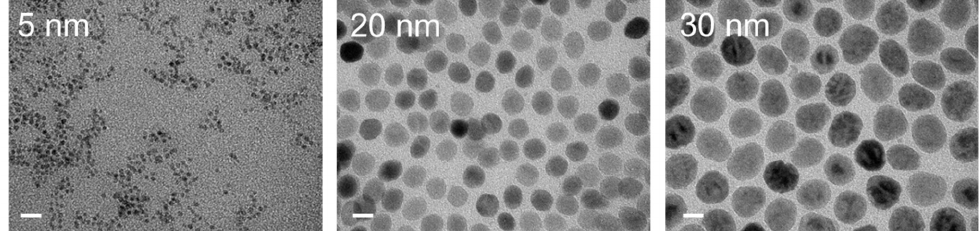
Figure 2. TEM images of various iron oxide nanoparticles with carboxylic acid. Bars = 20 nm.